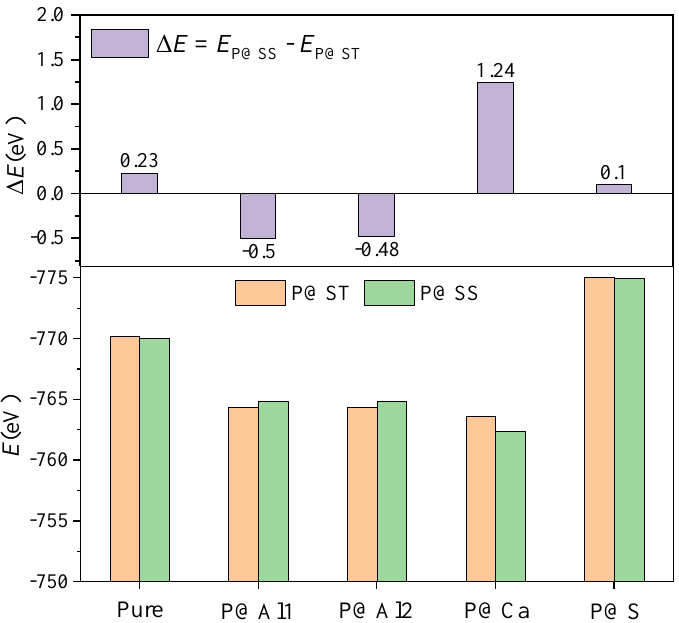
Figure 11. Static energies ( E , eV) of configurations with P substituting different atoms in P@ST and P@SS.